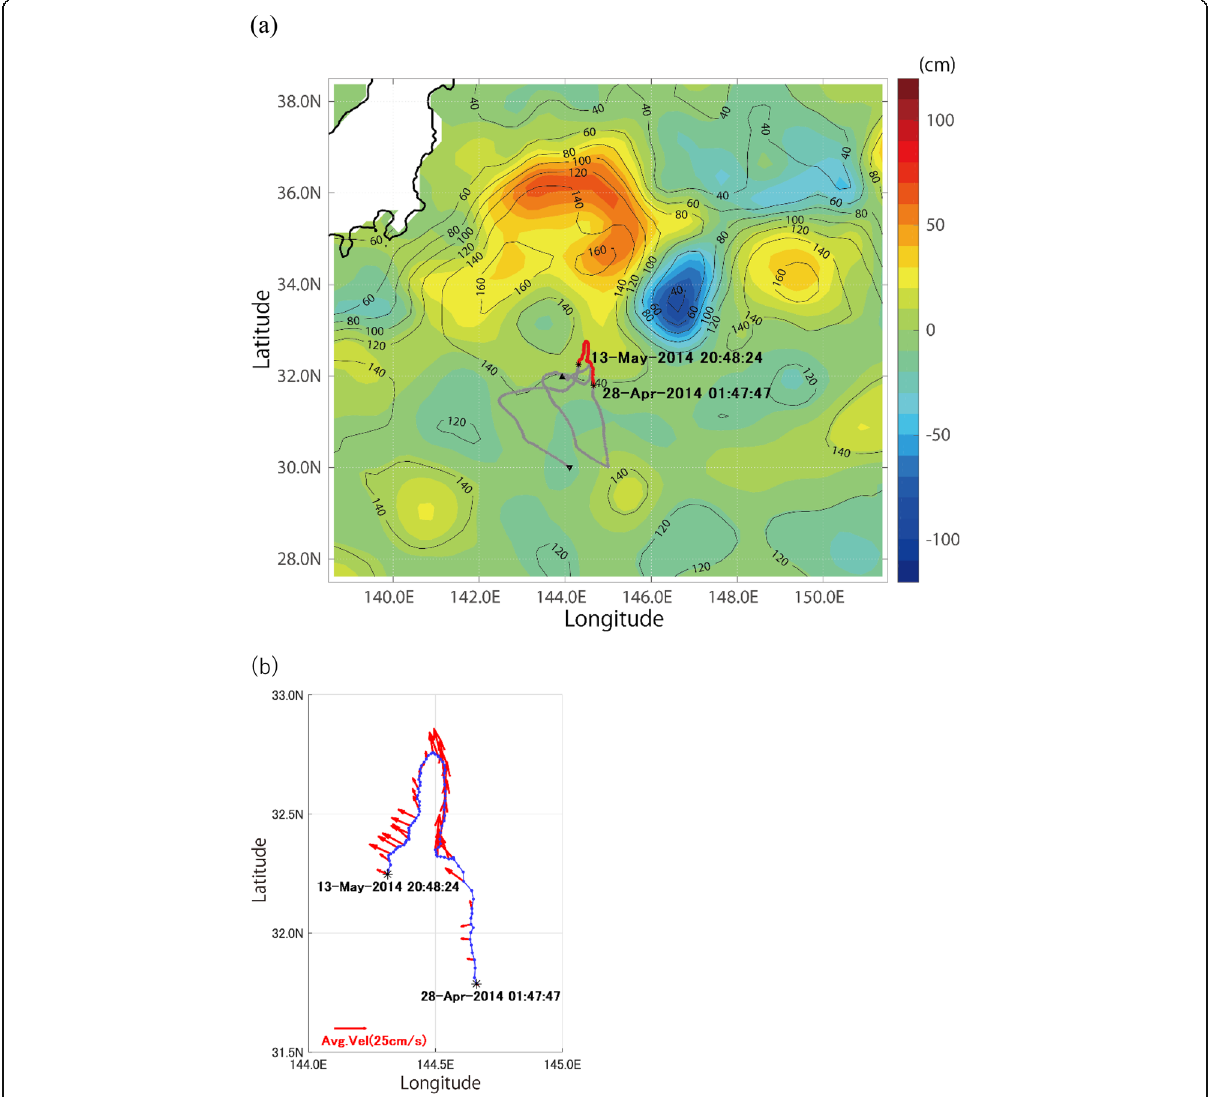
Fig. 1 a Trajectory of Seaglider for Feb. 27 – Jun. 21 (gray line). Red line indicates focused period from Apr. 28 – May 13. Background color and contours display mean sea level height anomaly (SSHA; cm) and absolute dynamic topography (ADT; cm), respectively, on May 1 based on the 0.25° × 0.25° daily mean merged gridded SSHA and ADT data set. b Vertically averaged horizontal current velocity (cm s − 1 ; red arrow plotted every third